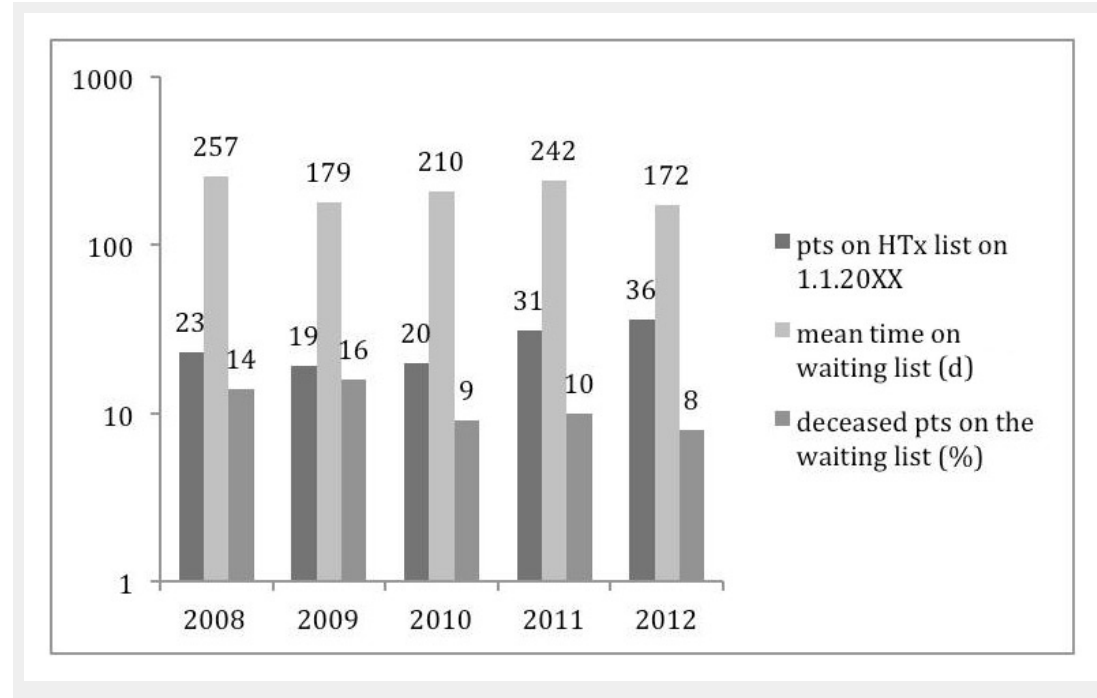
HTx waiting list characteristics (adapted from annual Swisstransplant